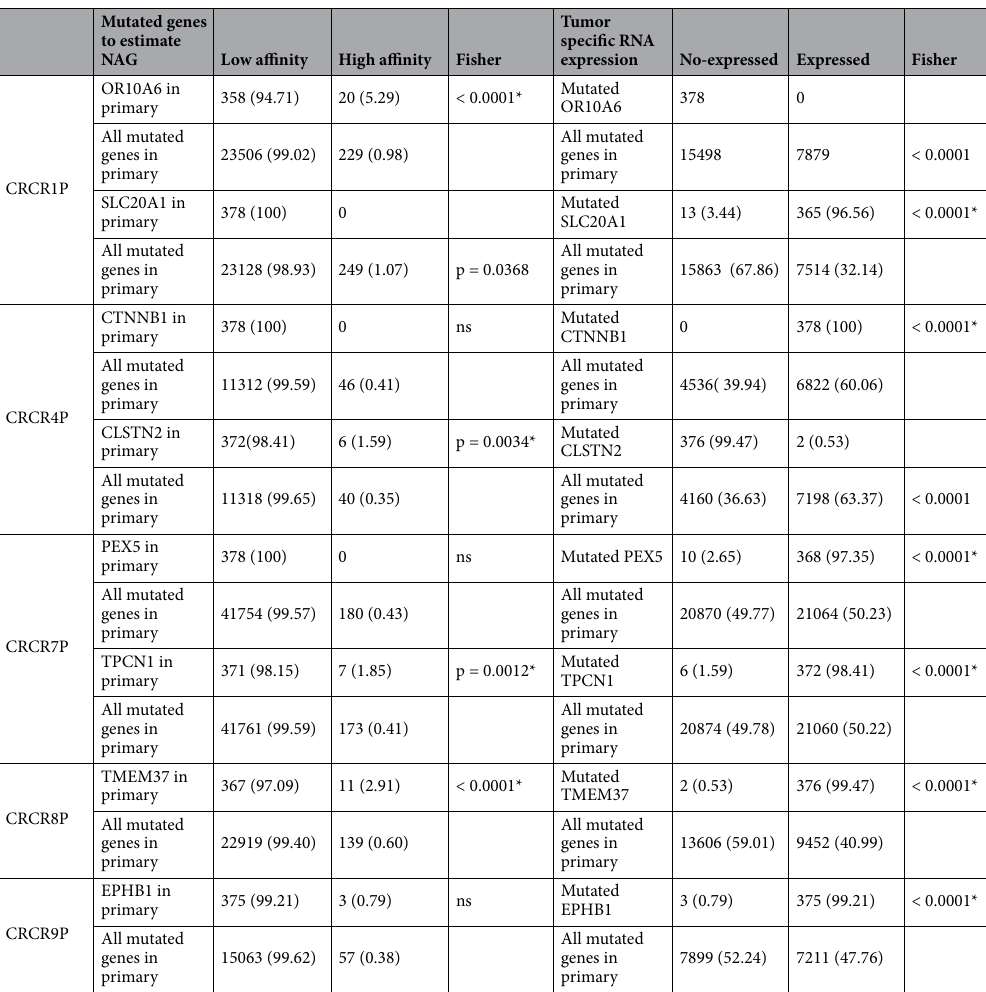
Table 2. C omparison of binding affinity to HLA and expression of tumor specific RNA between representative detetected mutated genes in ctDNA and primary specific mutations. Genes on panel (ctDNA): Detected genes on Cancer Panel by target sequencing. The cancer panel is consisted of common mutated genes betwen primary and recurrent sites. *p-value indicated the statistical significance of mutated genes in ctDNA compared to primary specific